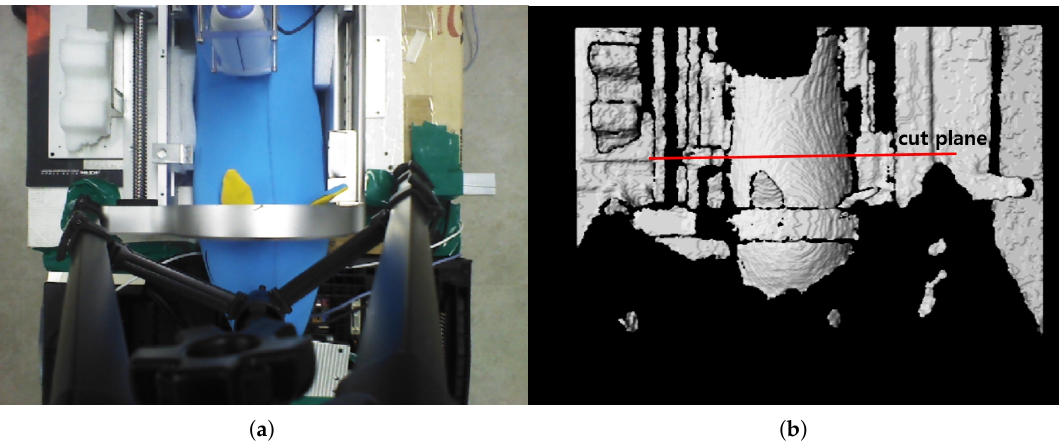
Figure 7. RGB and D data by the data acquisition program [41] after inserting a pig doll in the sarcopenia detection system. ( a ) RGB data. ( b ) D